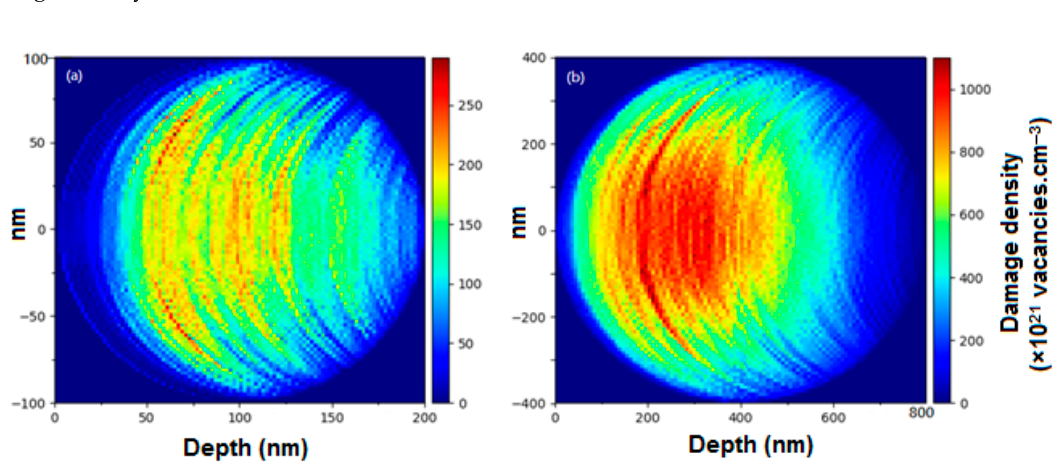
Figure 1. SRIM calculations modified using the SICMod code for a circular cross-section of spherical W NPs irradiated with 15 keV He to 1.1 × 10 17 ions · cm − 2 showing the damage density for diameters of ( a ) 20 nm and ( b ) 80 nm. (The colour scale units of damage density apply to both images.)